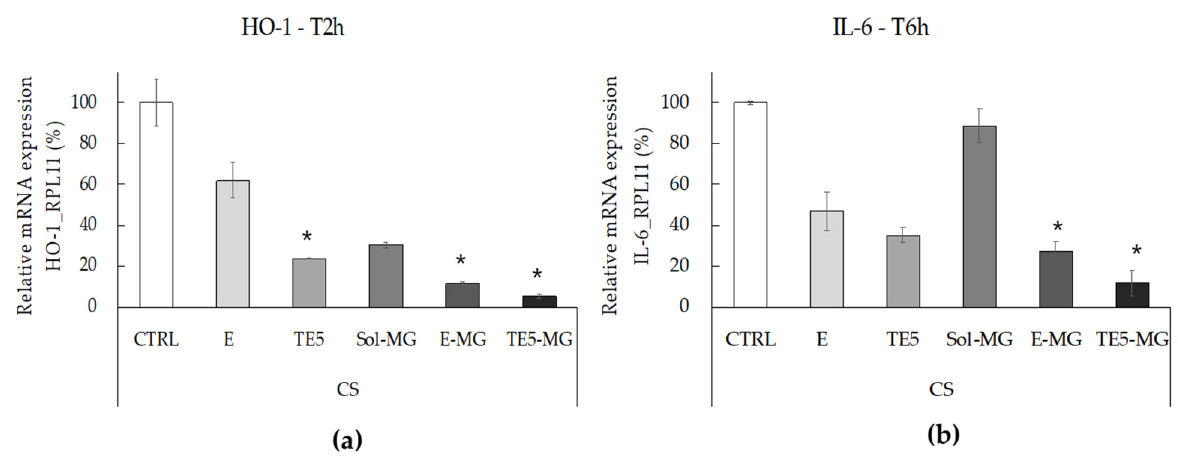
Figure 6. Antioxidant ( a ) and anti-inflammatory ( b ) effect of empty or MG-loaded vehicles on HaCaT cells exposed to CS for 30 min. Transcript levels of HO-1 ( a ) and IL-6 ( b ) were measured using qRT-PCR respectively 2 and 6 h post-exposure. Data are the results of the averages of at least three different experiments ± s.d. * p < 0.05 vs. CTRL sample by ANOVA.